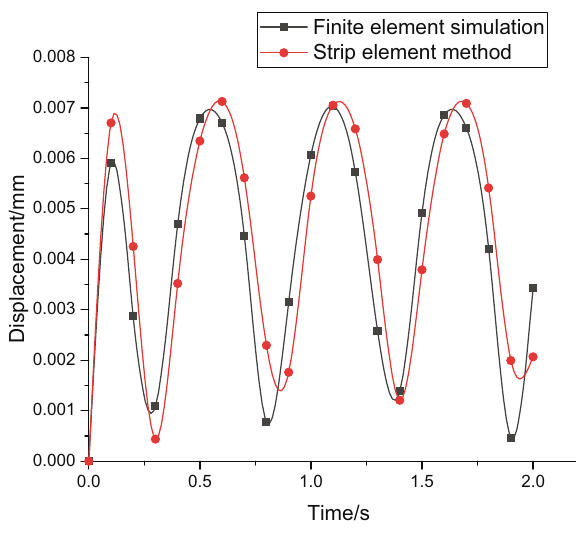
Figure 5: Veri fi cation of strip element method results and fi nite element results.